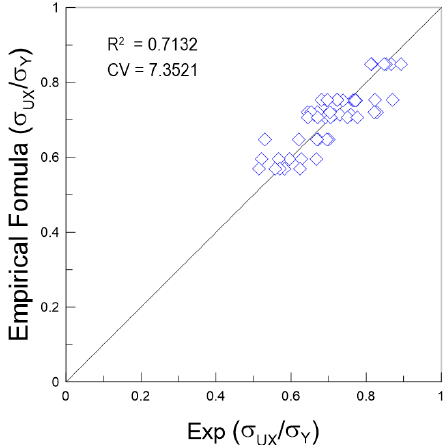
Figure 15. Correlation between the empirical formula with the ultimate strength of curved plates.